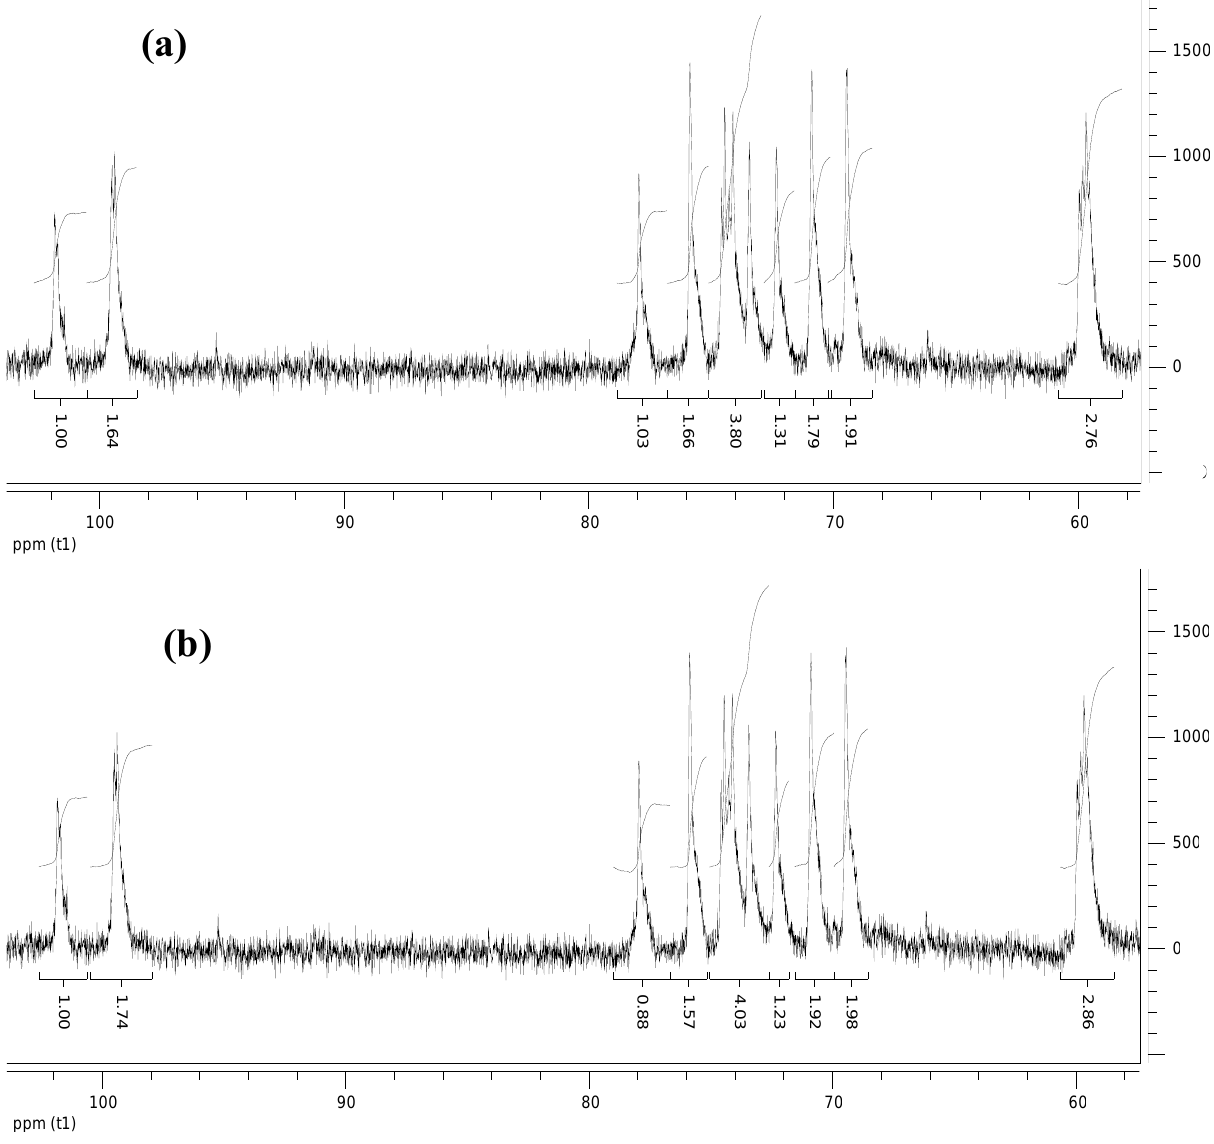
Figure 2. 13 C-NMR spectra of (a) KGM after 10 min degradation and (b) KGM after 60 min